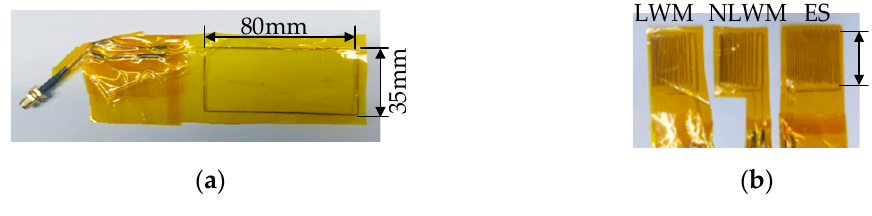
Figure 12. Picture of the coils: ( a ) linear coil; ( b ) LWM, NLWM and ES coil.